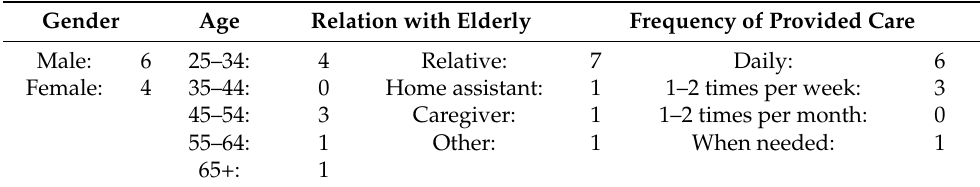
Table 12. Characteristics of participants from caregivers user group.